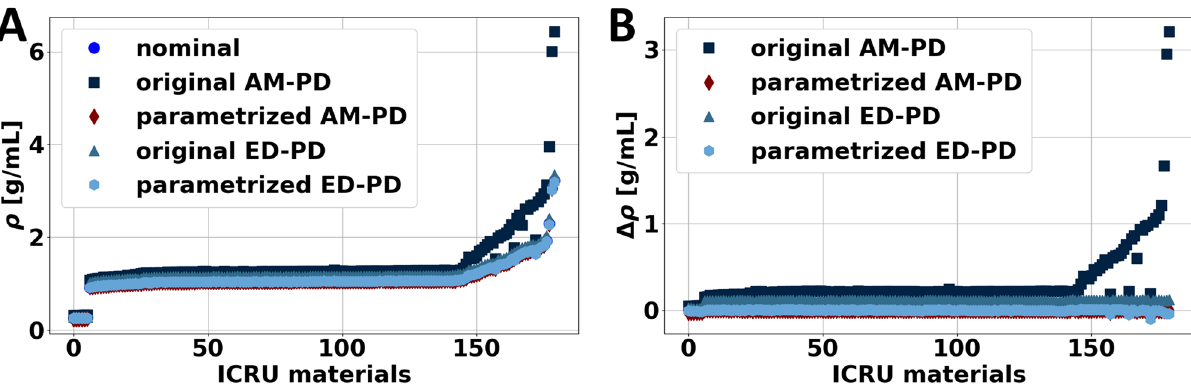
Figure 2. Physical density of ICRU materials calculated with theoretical and parameterized AM-PD and ED-PD models. Model development involved materials with a range of physical density values ( A ). Parametrized AM model performed well in comparison to theoretical questions and parametrized ED-PD model as evidenced by low differences between calculated and nominal values ( B